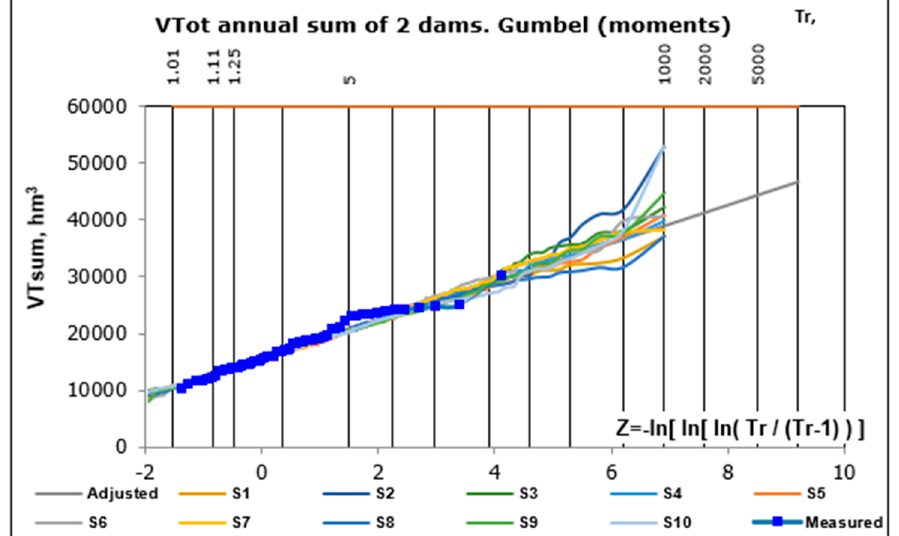
Figure 3. Probability distribution functions for the historical series and the 10 synthetic series generated with the modified Svanidze method.